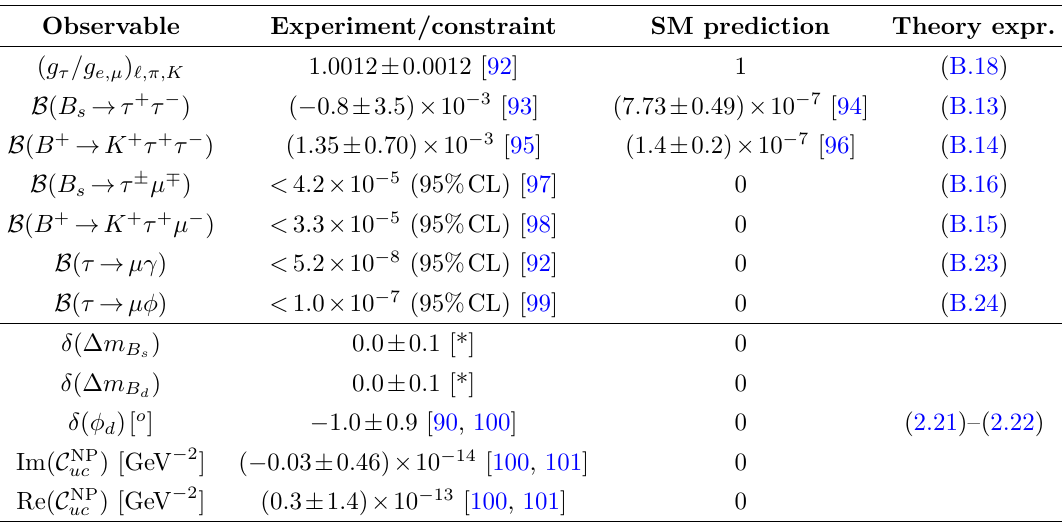
Table 3 . Low-energy observables included in the fit of the U 1 couplings (in addition to the ob- servables in tables 1 and 2). The entries marked with a [*] denote our constraint imposed on the magnitude of the ∆ F = 2 amplitudes (see text for further